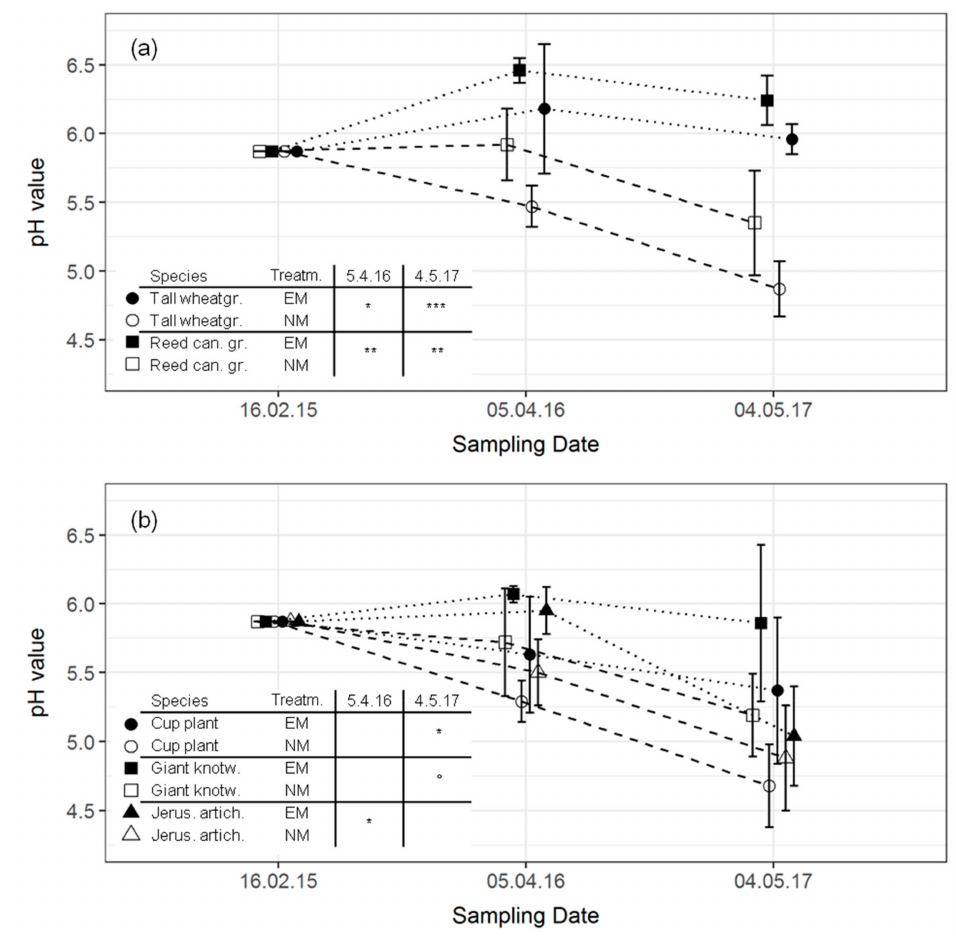
Figure 5. Change of soil pH value (mean values ± standard deviation, n = 5) as a ff ected by di ff erent soil moisture treatments and plant species ( n = 5). For reasons of readability, the figure was split into subplots of ( a ) grasses and ( b ) forbs species. Significant di ff erences between both soil moisture treatments (‘EM’: excess soil moisture, ‘NM’: non-excess soil moisture) of a certain plant species at single sampling dates are indicated as follows: ◦ : < 0.10, *: < 0.05, **: < 0.01, ***: <